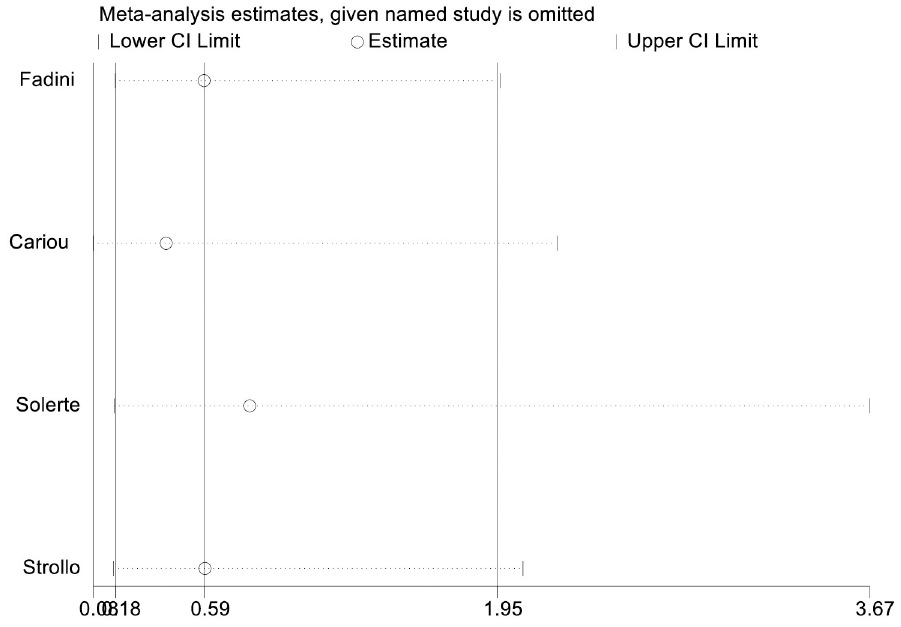
Fig 4. Sensitivity analysis of the effect DPP-4i use on the mortality of COVID-19.